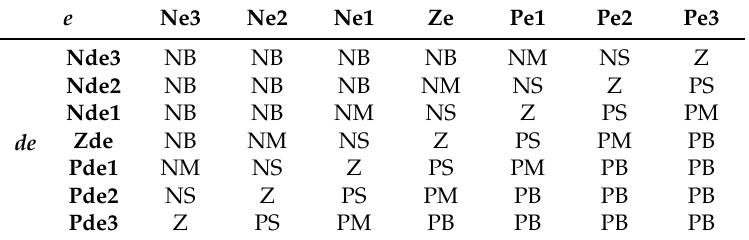
Table 1. Fuzzy rules of the three-phase induction motor (TIM) speed